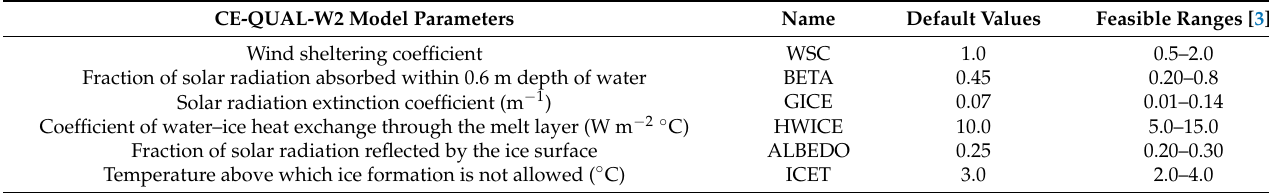
Table 1. The six CE-QUAL-W2 parameters and the ranges of their values that are calibrated for simulating water temperature in Devils